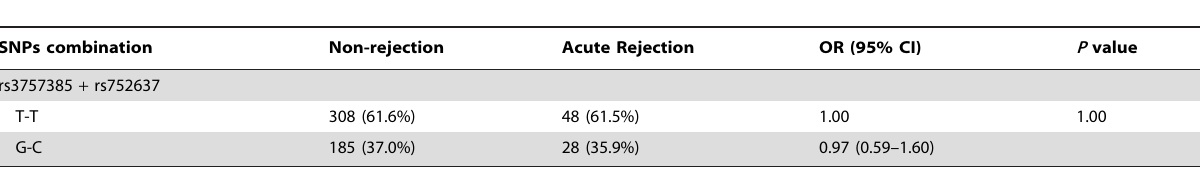
Table 3. Association of IRF5 Haplotype with acute